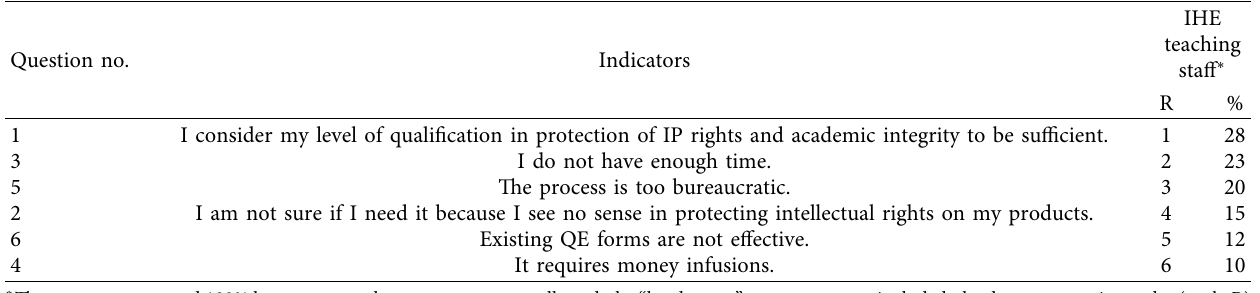
Table 7: Motivations for qualification